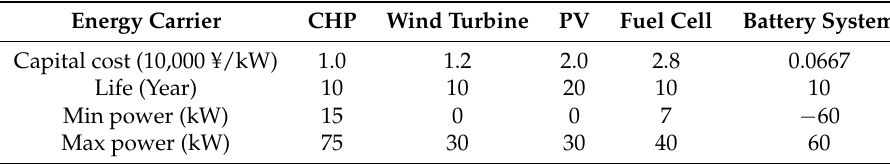
Table 1. The rated parameters of the traditional microgrid.